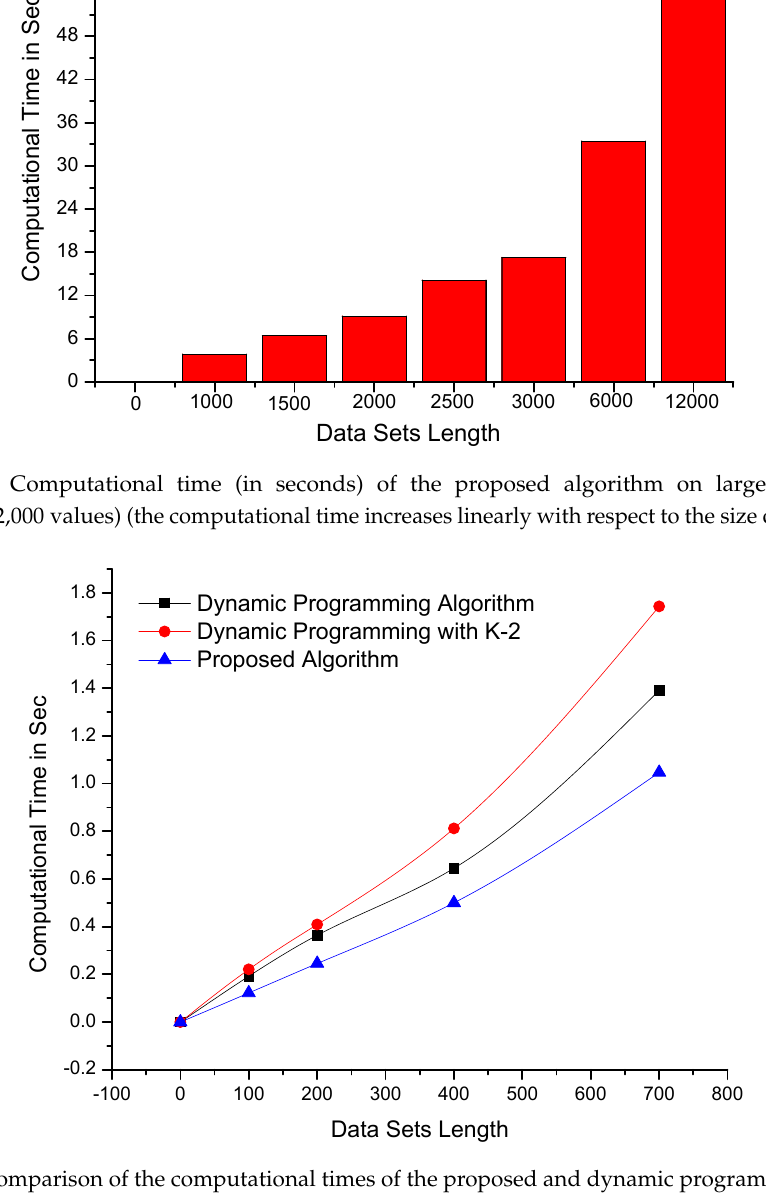
Figure 6. Comparison of the computational times of the proposed and dynamic programming-based algorithms using data sets of constant length and dimensionality. The lowest lines (i.e., the minimum values) reflect better